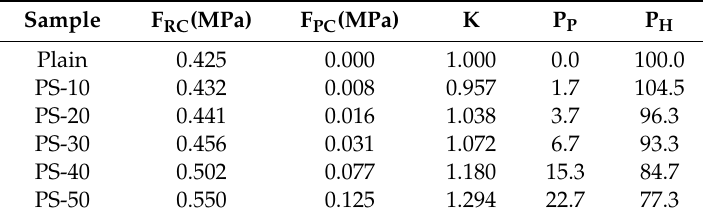
Table 5. Integrate performance of the pozzolanic activity of phosphorus slag in cement mortars at 28 days.